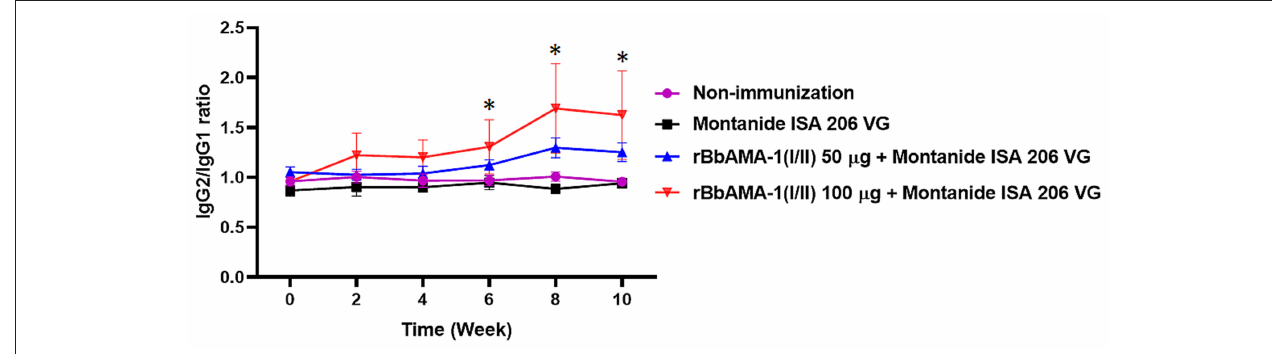
FIGURE 3 | Time course of IgG2/IgG1 ratio response to rBbAMA-1(I/II) assessed by indirect ELISA. Each time point depicts the group mean value ± SD of the IgG2/IgG1 ratio. Asterisks indicate a significant difference ( P <